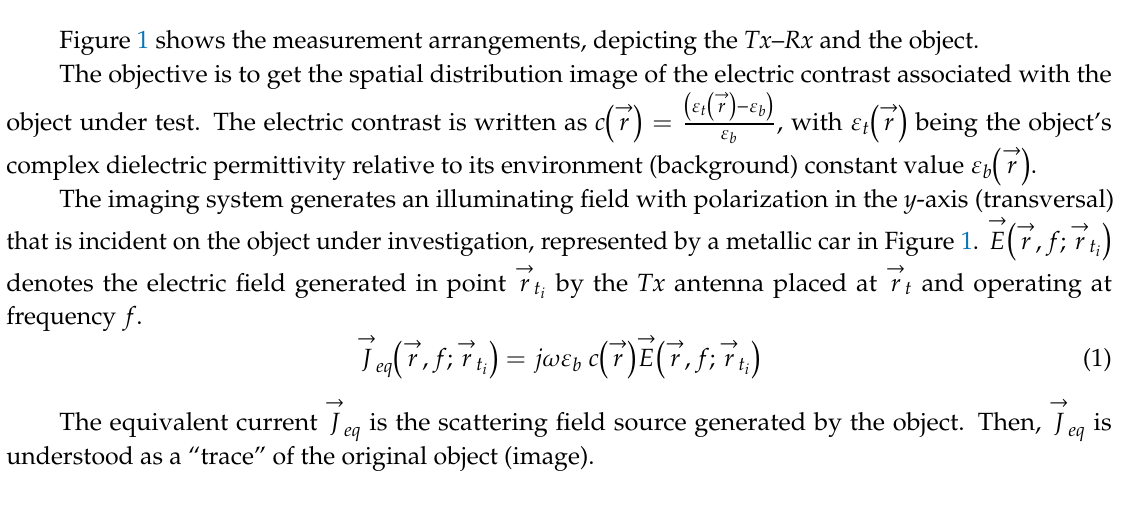
Figure 1. Measurement arrangements to explore the object in an XY plane using a positioning table.